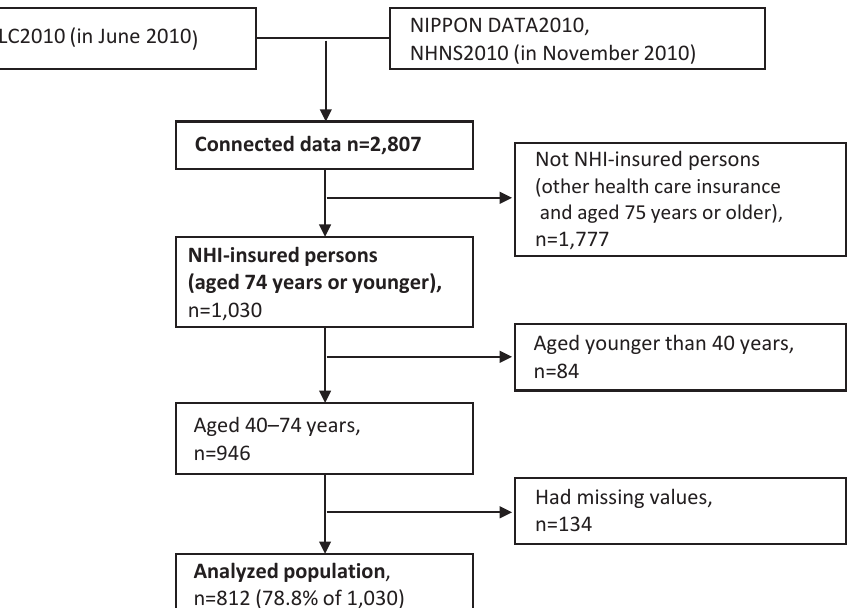
Figure 1. Study population: NIPPON DATA2010. CLCS2010, Comprehensive Survey of Living Conditions 2010; NHI, National Health Insurance; NHNS2010, National Health and Nutrition Survey of Japan 2010; NIPPON DATA2010, National Integrated Project for Prospective Observation of Non-communicable Disease and its Trends in the Aged